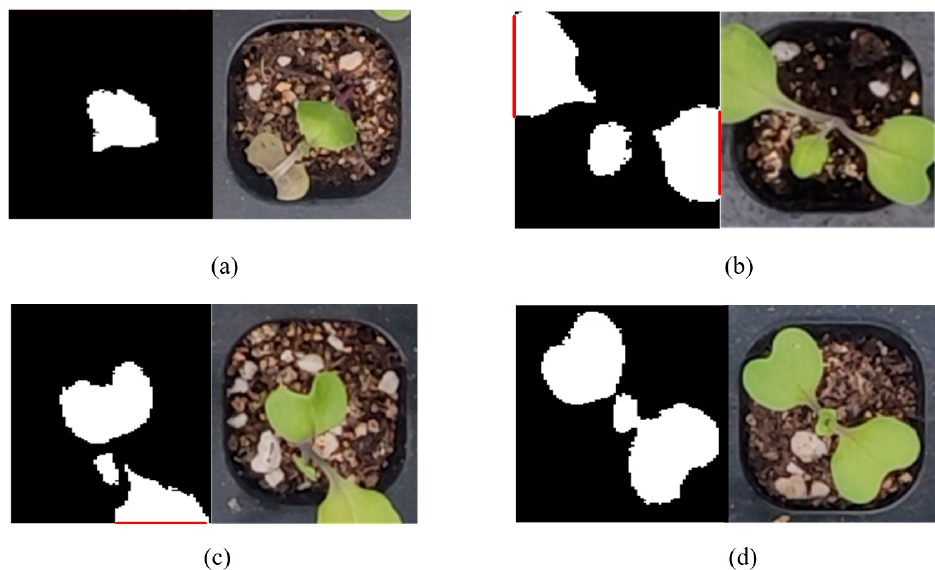
Figure 3. Four kinds of seedling identification results: ( a ) inferior seedlings, ( b ) left and right cross- border healthy seedlings, ( c ) up and down cross-border healthy seedlings, and ( d ) healthy seedlings that do not cross the border.